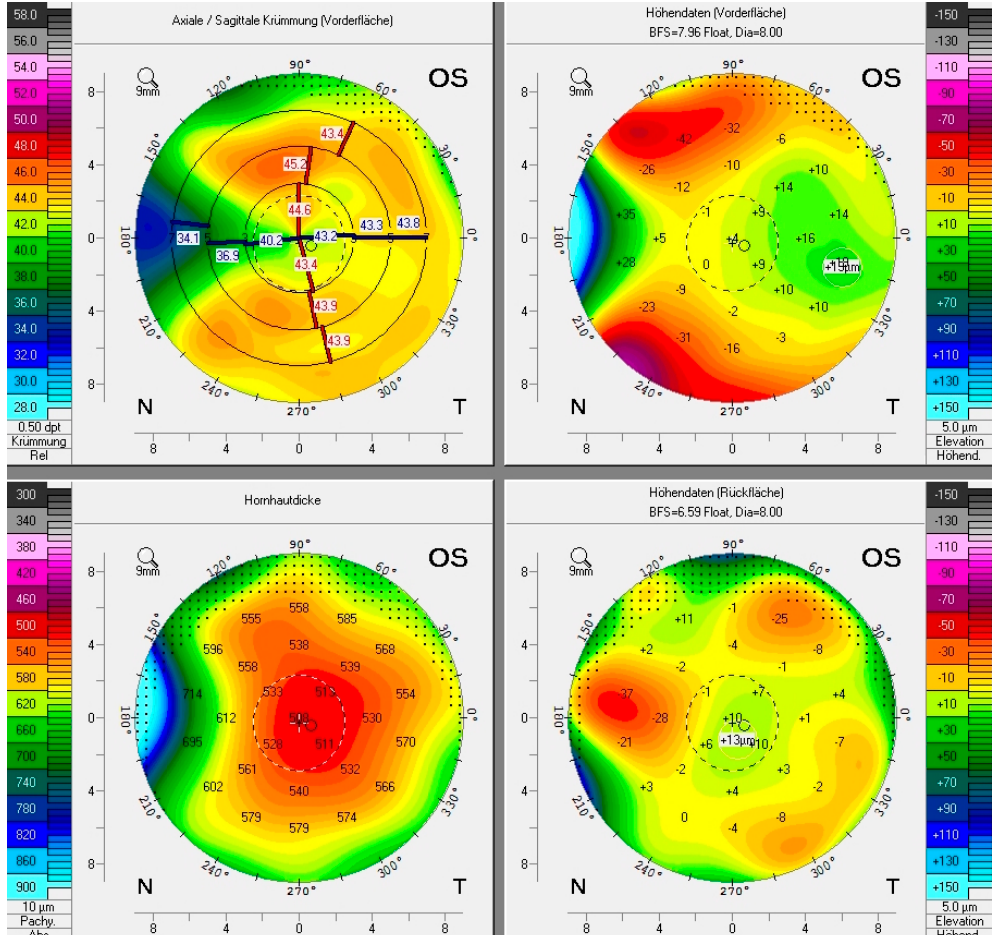
Figure 7. A typical Pentacam display of the same nasal pterygium shown in Figure 5. Clockwise starting from top left: anterior sagittal curvature map, anterior elevation map, posterior elevation map, corneal thickness map (pachymetry). The pterygium thickens and flattens the peripheral nasal cornea and thus reduces local refractive power.